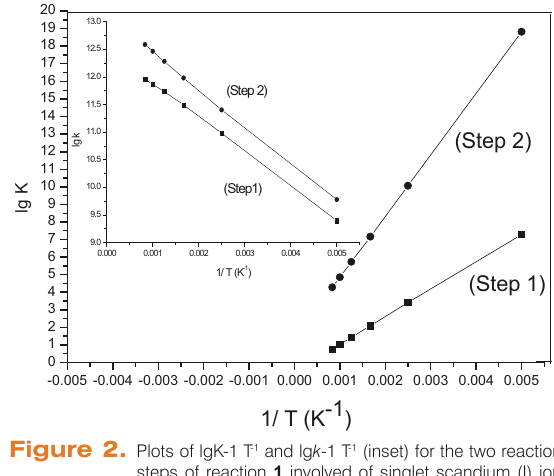
Figure 2. Plots of lgK-1 T -1 and lg k -1 T -1 (inset) for the two reaction steps of reaction 1 involved of singlet scandium (I) ion and SCO along the C-O bond activation